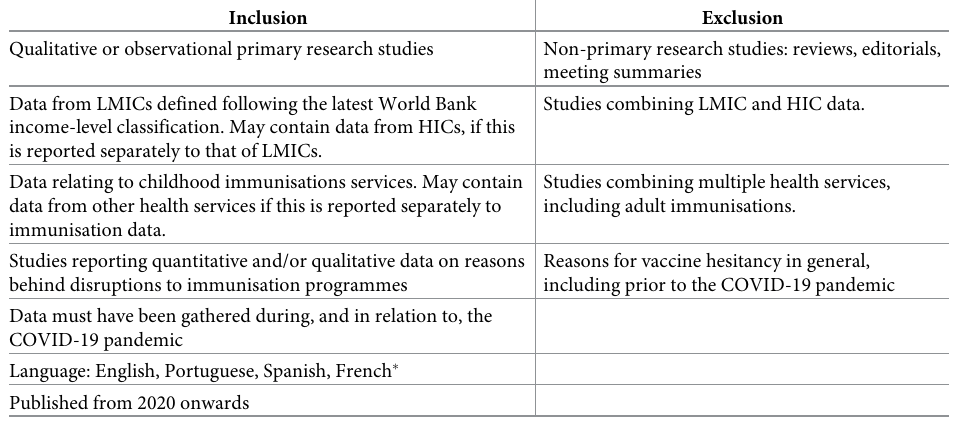
Table 1. Summary of inclusion and exclusion criteria for studies reporting levels of disruption and/or reasons for